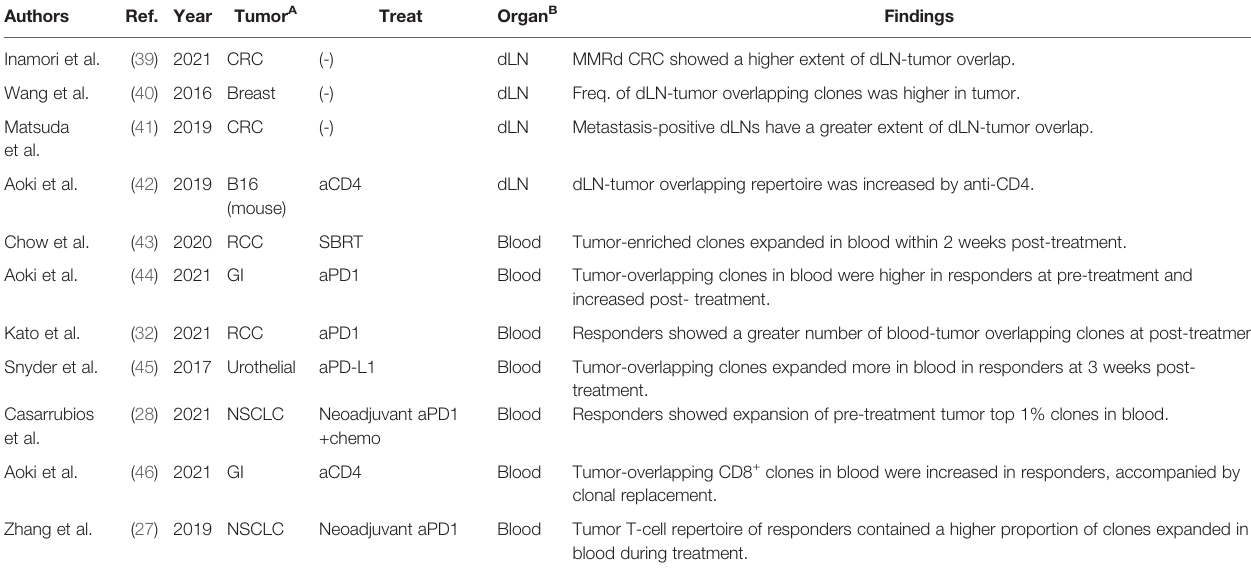
TABLE 4 | Previous studies performing bulk TCR sequencing inter-organ clone tracking analysis.